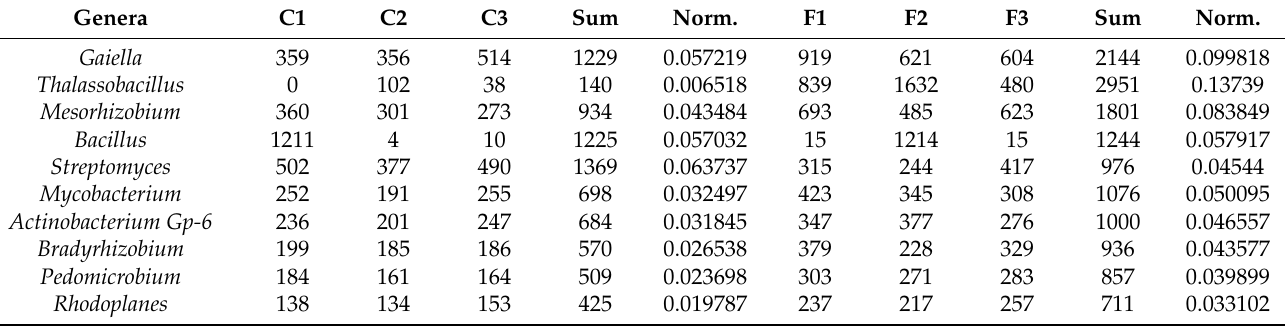
Table 2. Read counts of the top ten most abundant OTUs for each soil microcosm sample. Control samples: C1, C2, and C3 and Fipronil samples: F1, F2, and F3. Norm is normalization (the mean relative abundance).